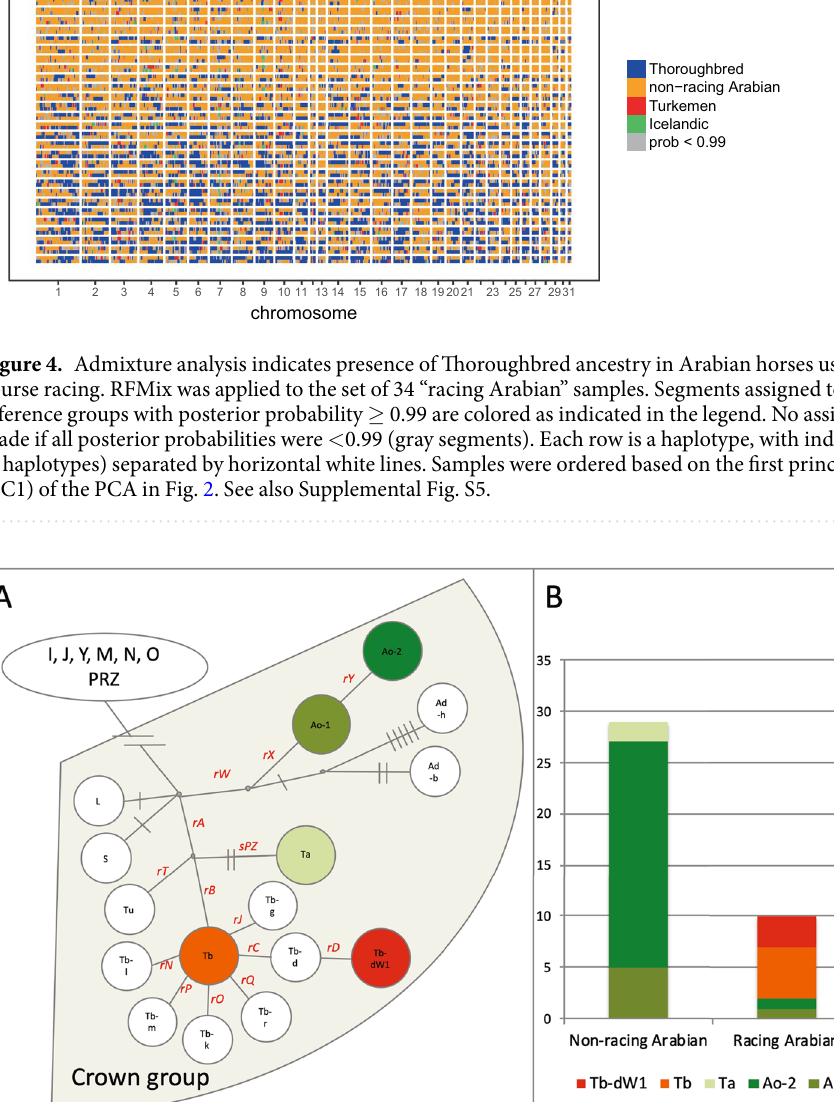
gence of the “Whalebone” haplotype in the 1800s.